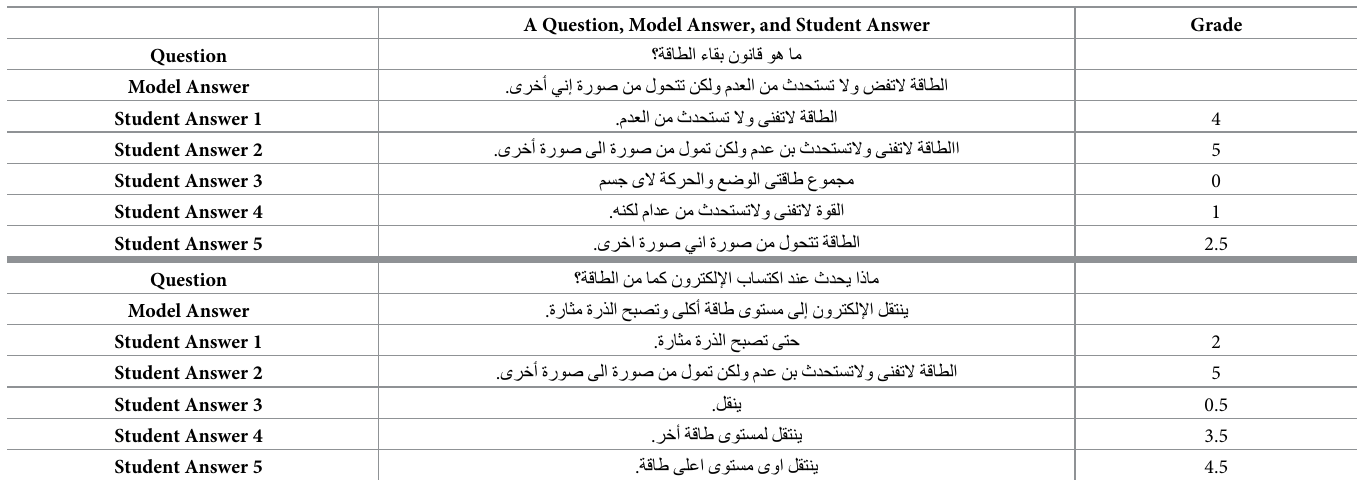
Table 2. A sample question, model answer, students’ answers, and grades.